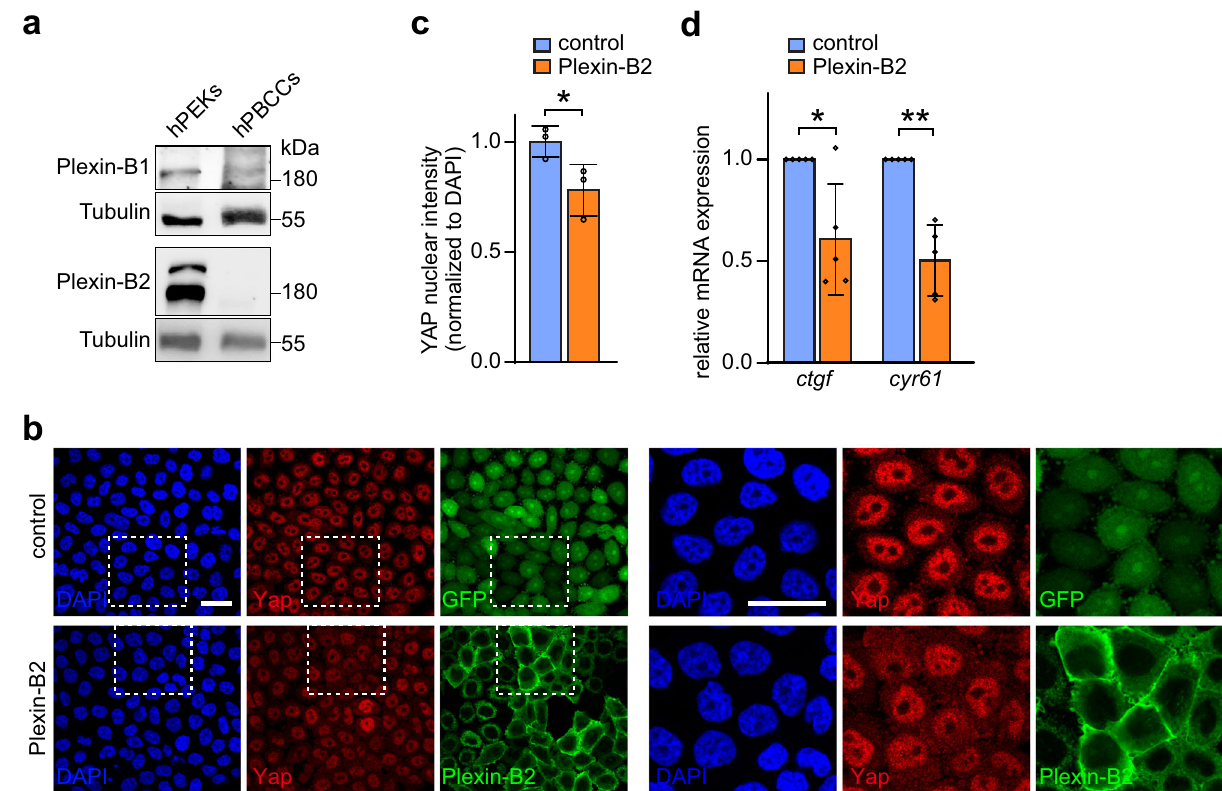
Fig. 7 B-plexins suppress YAP activity in human basal cell carcinoma cells. a Human primary epidermal keratinocytes (hPEKS) and human primary basal cell carcinoma cells (hPBCCs) were lysed, and proteins were detected using the indicated antibodies. b , c hPBCCs engineered to express GFP ( “ control ” ) or myc-tagged Plexin-B2 ( “ Plexin-B2 ” ) and cultured at dense conditions were immunostained for YAP (red) and myc (green). Blue: DAPI. Representative confocal images are shown in b with dashed boxed areas depicted in the right panel. A quanti fi cation of YAP nuclear intensity is shown in c (mean ± s.d.; n = 3 independent experiments; p = 0.0495; two-sided unpaired t -test). d hPBCCs were engineered to express GFP ( “ control ” ) or myc-tagged Plexin-B2 ( “ Plexin-B2 ” ), and cultured at dense conditions. Relative mRNA expression levels of the YAP target genes ctgf and cyr61 were determined by quantitative RT-PCR (mean ± s.d.; n = 5 independent experiments; p = 0.0123 for ctgf , p = 0.0002 for cyr61 ; two-sided unpaired t